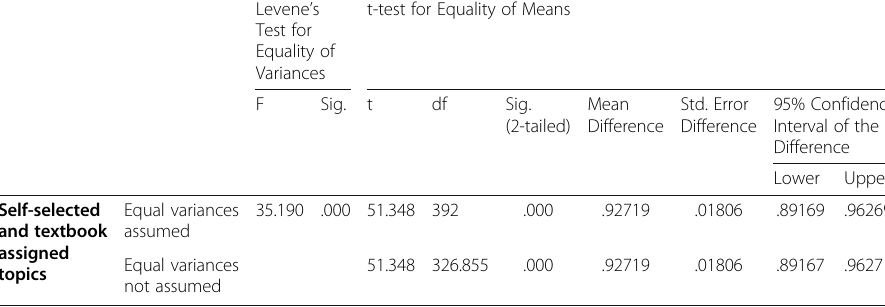
Table 16 The Results of T-Test to Compare the Results of Learners ’ Perception of Textbook- Assigned and Self-Selected Topics Regarding Topic Interest, Familiarity, Importance, and Difficulty